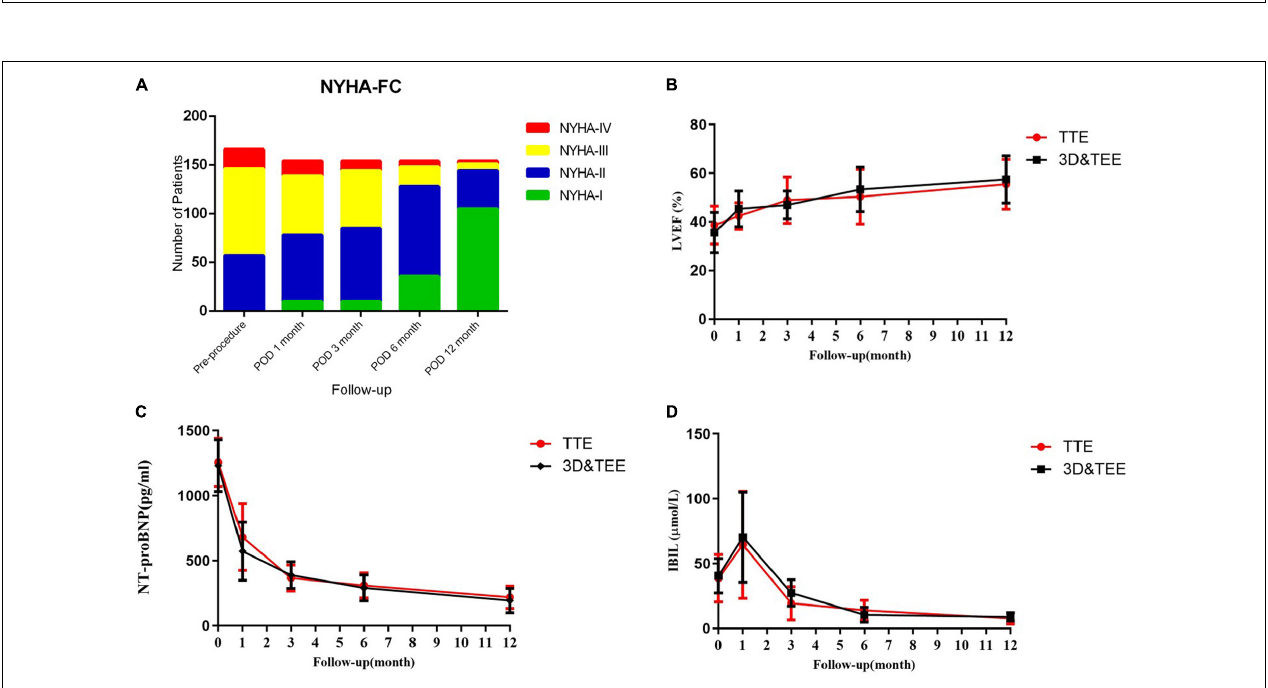
FIGURE 6 | Echocardiograms taken during the follow-up period. (A) TTE shows the mitral PVL after the procedure. (B) TTE shows the mitral PVL closed with the occluder. (C) The mitral PVL is closed with 2 occluders with TEE guidance. (D) The mitral PVL is closed with 2 occluders under 3D TEE guidance.